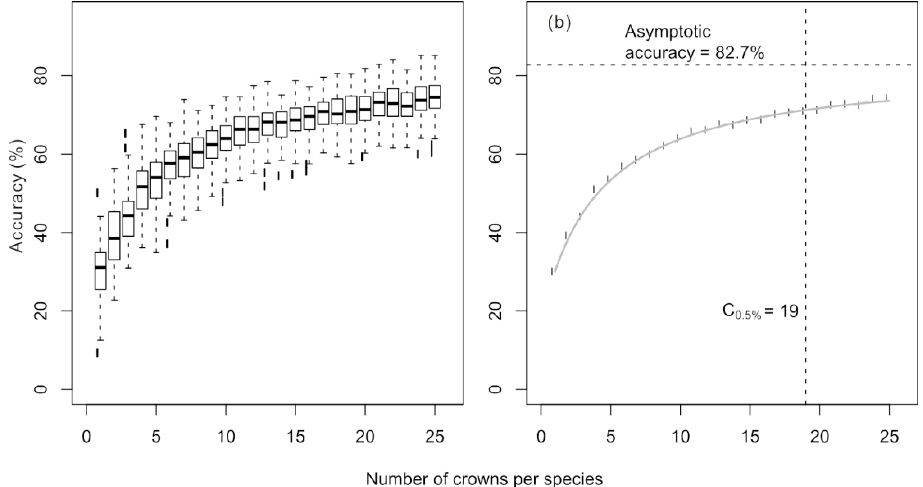
Figure 2. The relationship between the number of training crowns per species ( n ) and classification accuracy for the full species model containing all 11 species. ( a ) Box-and-whisker plots of the overall pixel-level accuracy estimated over 100 trials for each value of n ; ( b ) The mean values of the results in ( a ) with the fitted modified Michaelis-Menten function. The asymptotic accuracy estimated from the fitted function is given by the dashed horizontal line and the number of crowns needed to produce “good” ) is given by the dashed vertical accuracy results (C 0.5%